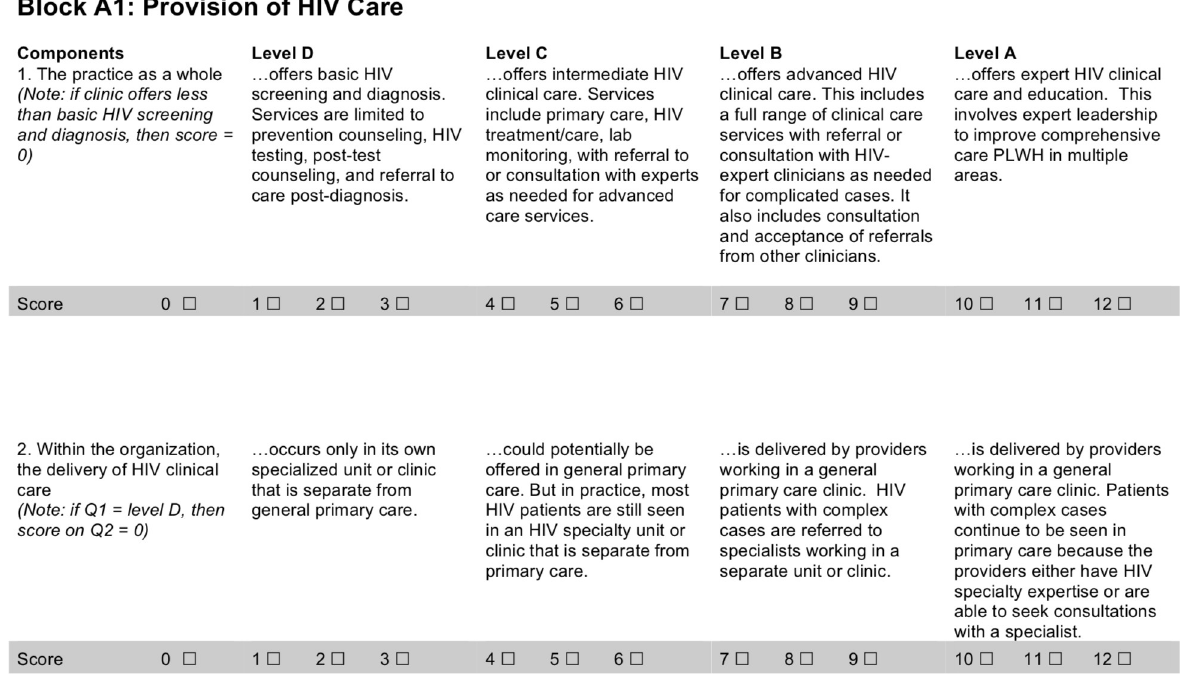
Fig 1. Example of HIV-specific supplemental items from the organizational assessment. PLWH, people living with HIV.